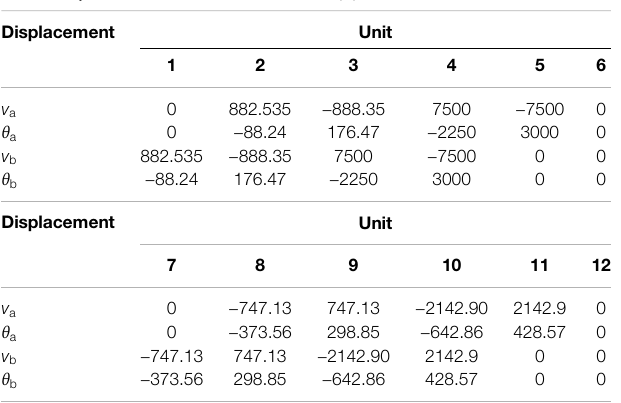
TABLE 3 | Values of force residual vector P (N).